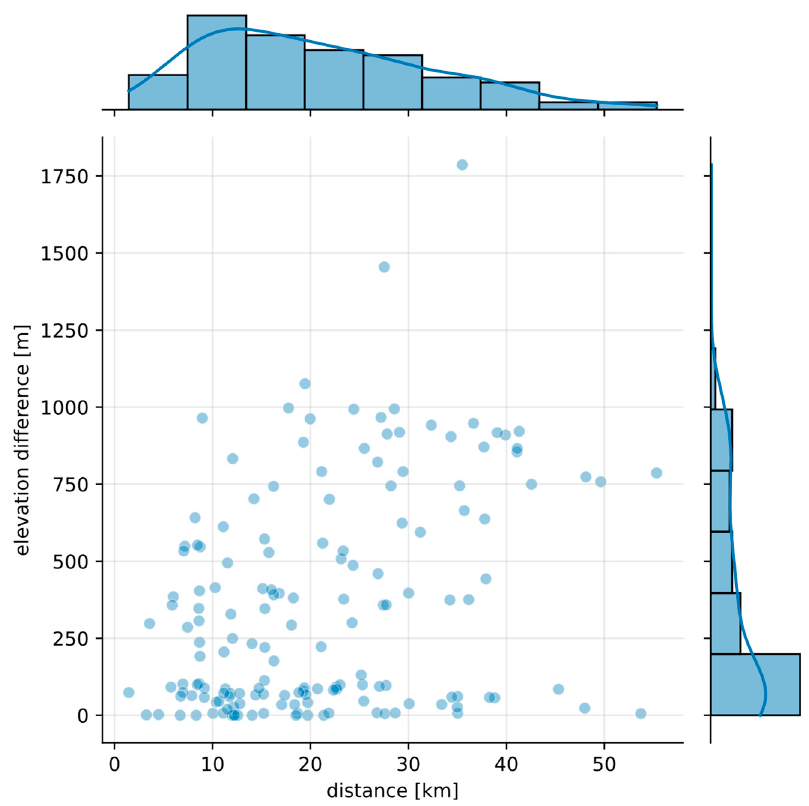
Figure 3. Statistical analysis of the network: elevation difference vs. distance.